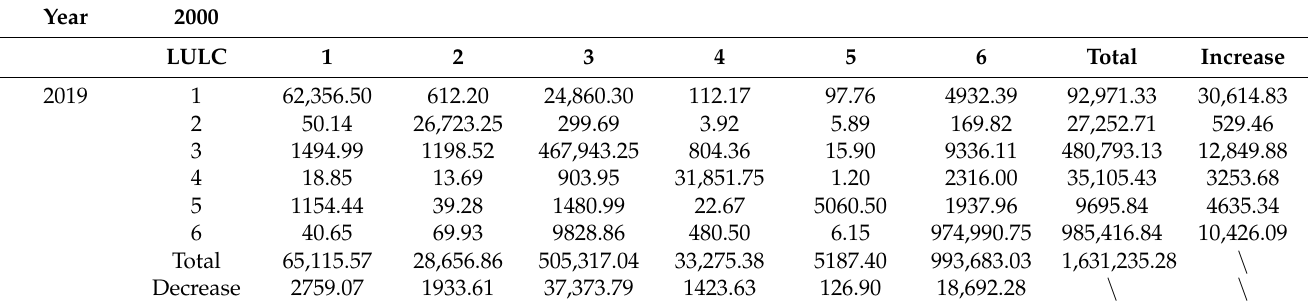
Figure 10. ( a ) dynamics of arable land from 2000 to 2019; ( b ) dynamics of construction land from 2000 to 2019. Table 2. Transfer matrix of LULC in Xinjiang from 2000 to 2019 (km 2